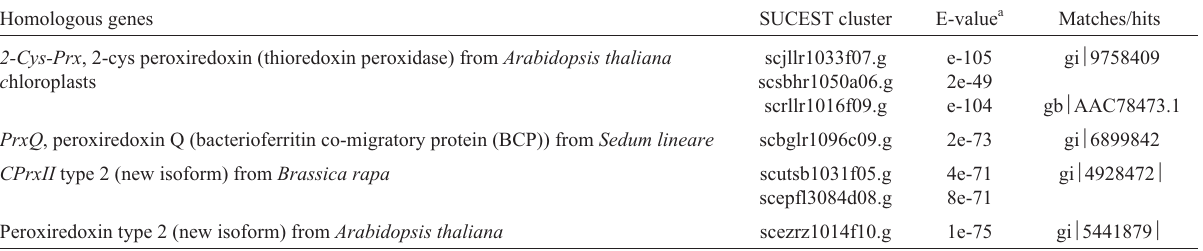
Table VIII - Peroxiredoxin homologues in